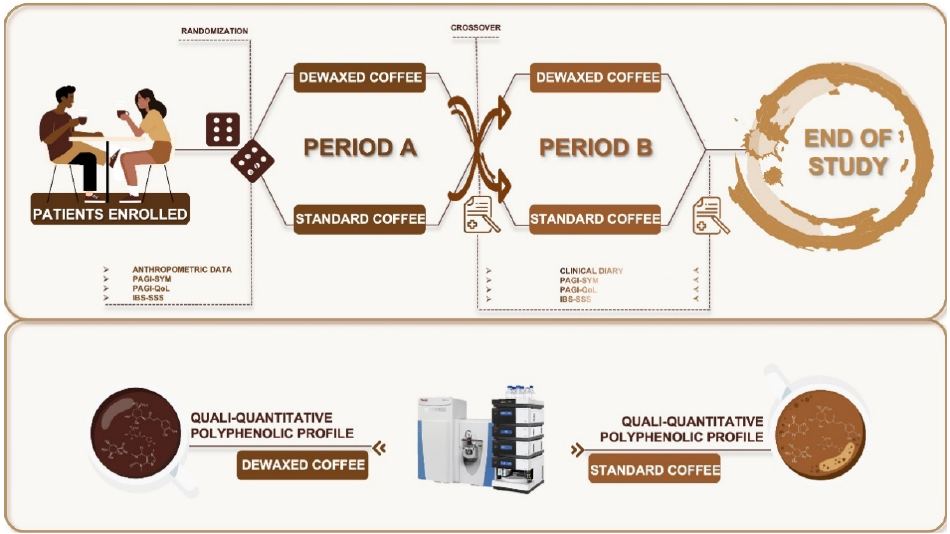
Figure 1. Visual description of study design. IBS-SSS, Irritable Bowel Syndrome—Symptom Severity Scale; PAGI-QoL, Patient Assessment of Upper Gastrointestinal Disorders-Quality of Life; PAGI-SYM, PAGI-Symptoms Severity Index.